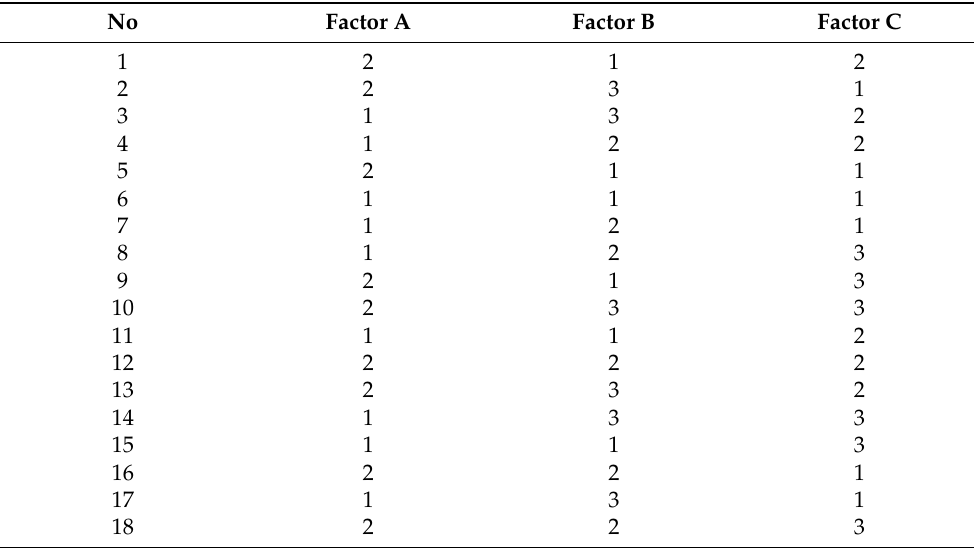
Table 3. Taguchi orthogonal array design L 18